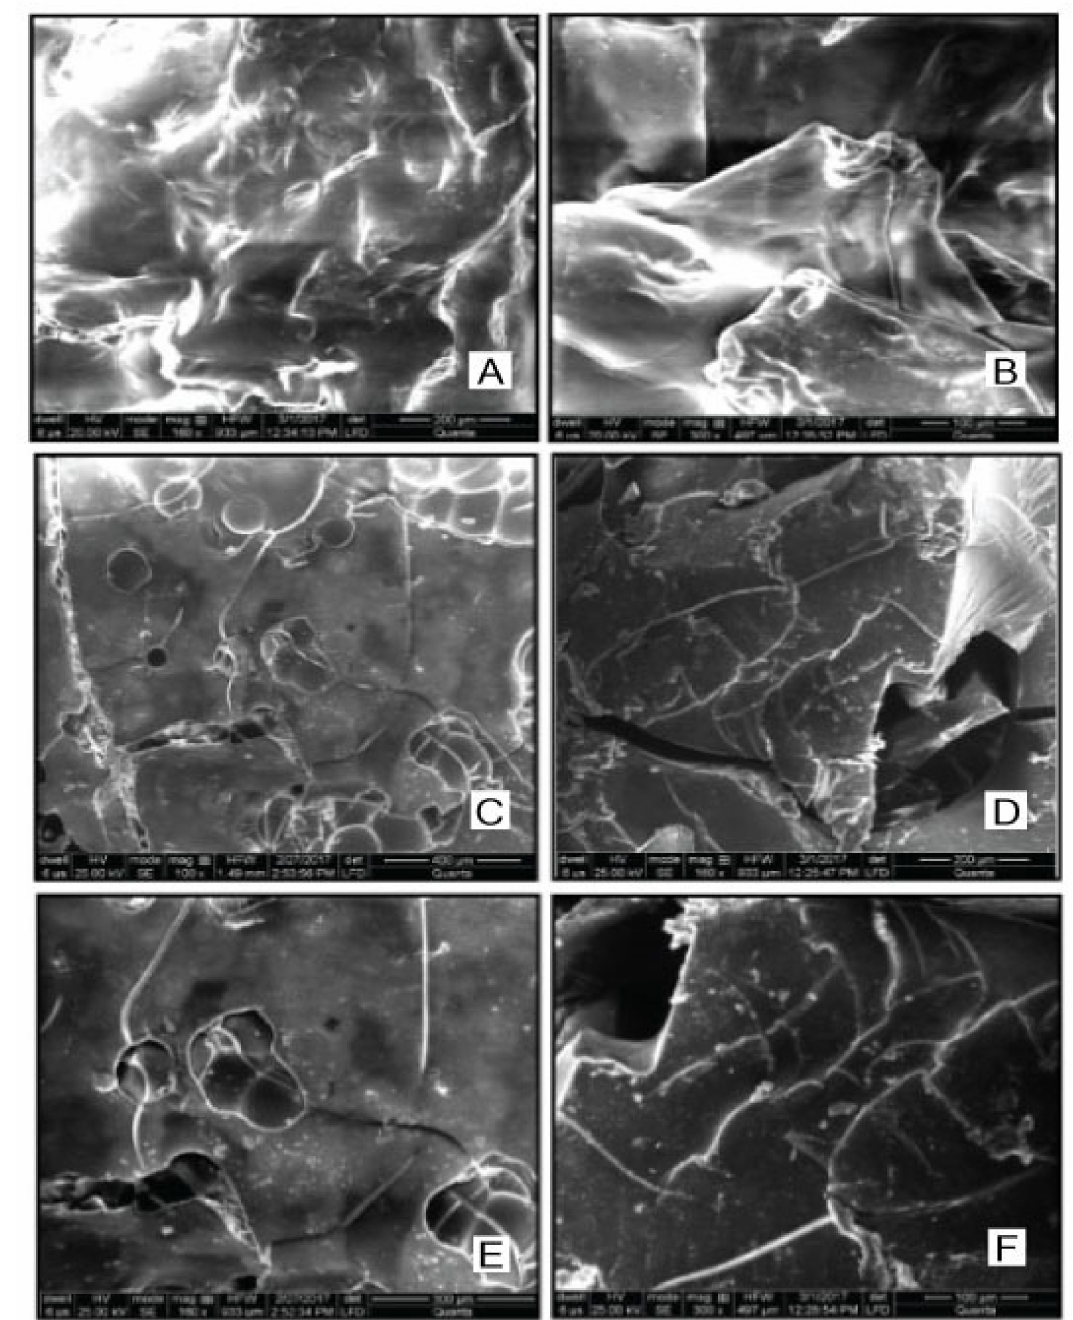
Figure 6. SEM image of F1 linseed-co-AAM formulation hydrogel with 100 µ m ( A ) and 200 µ m ( B ), F3 hydrogel with 300 µ m ( C ) and 400 µ m ( D ), F7 hydrogel with 100 µ m ( E ) and 200 µ m ( F )